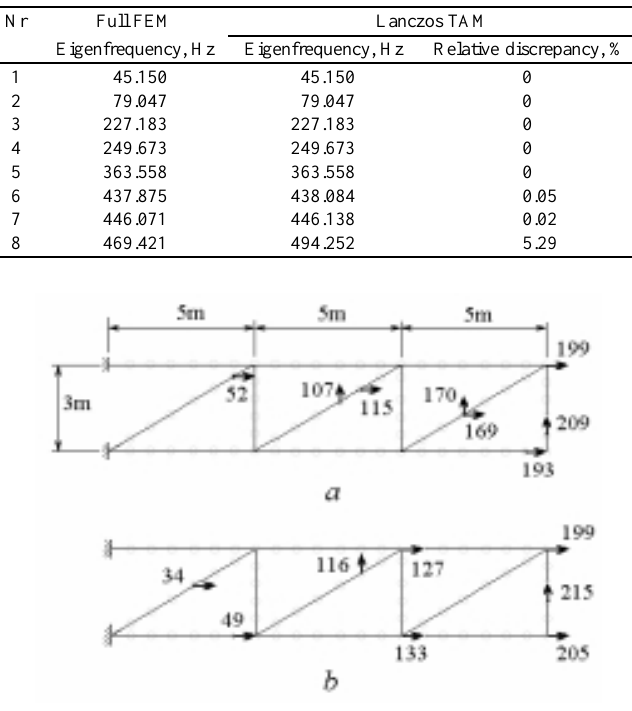
Fig. 4. Selection of eight active DOFs using: a) Schur vectors, b) Lanczos